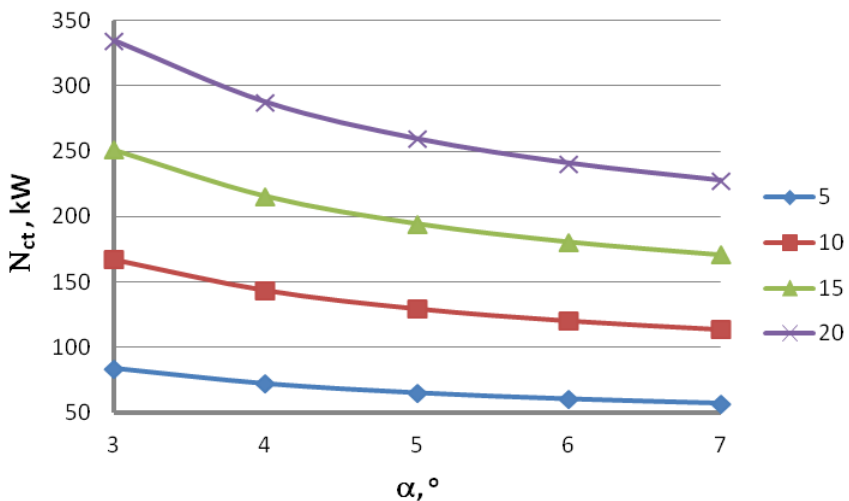
Figure 2. Influence of the drawing angle on the total drawing power N ct of the wire with an initial diameter of 5.5 mm and end diameter of 2.2 mm for wires drawn with speed v = 5, 10, 15, 20 m/s.